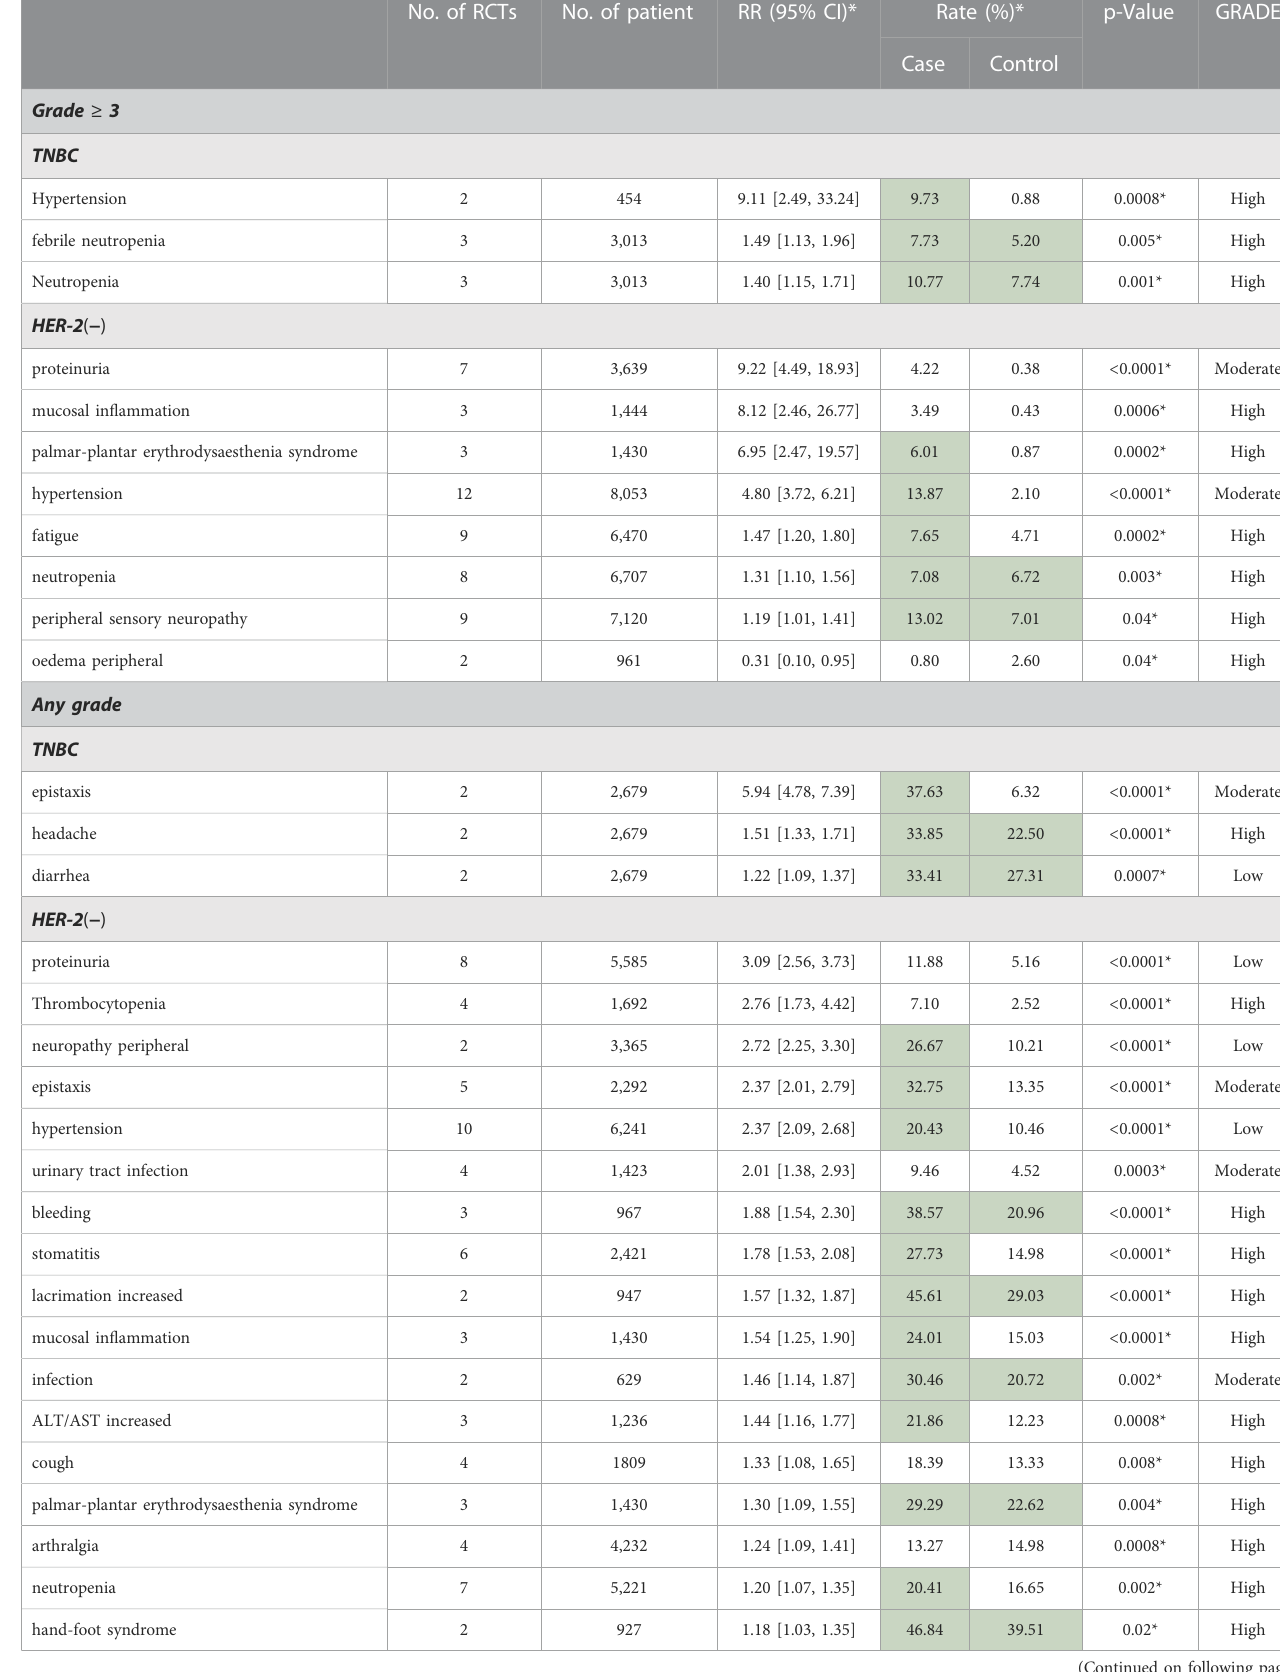
TABLE 4 Subgroup outcome of Type of